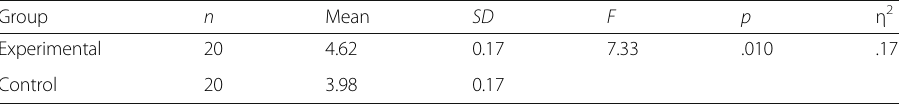
Table 3 Effects of treatment on oral communication performance